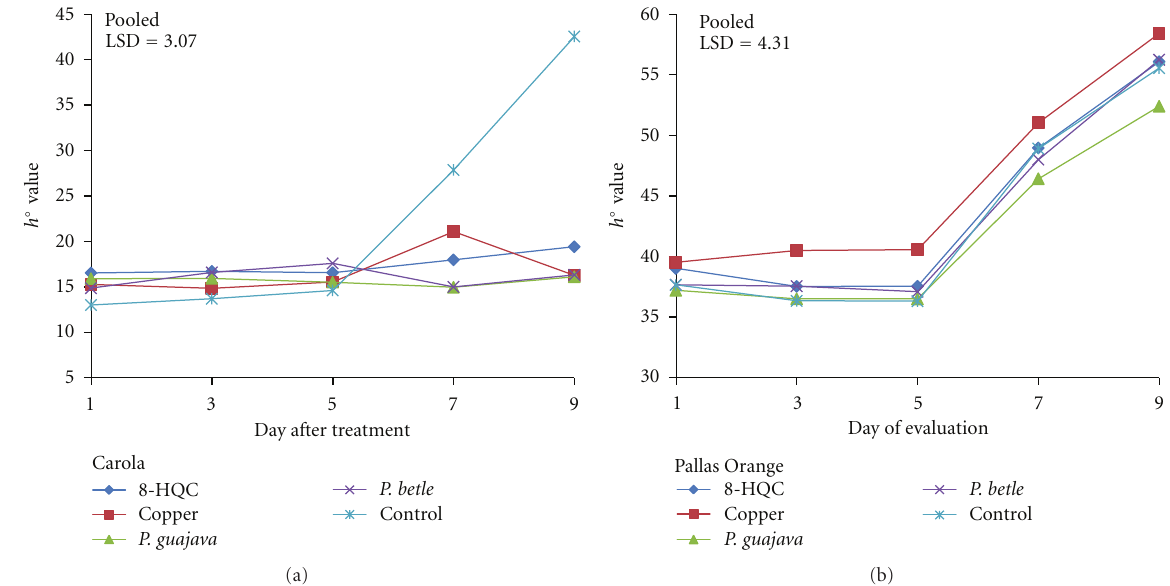
Figure 5: E ff ect of 8-HQC, copper coin, and leaf extracts of P. guajava and P. betle and control on h ◦ value of (a) “Carola” and (b) “Pallas Orange” cut carnation flowers.